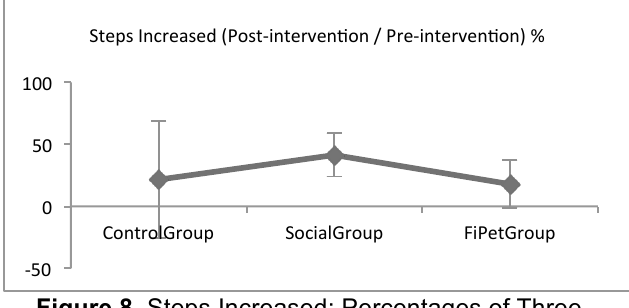
Figure 8. Steps Increased: Percentages of Three Conditions after Intervention Compared to Pre-